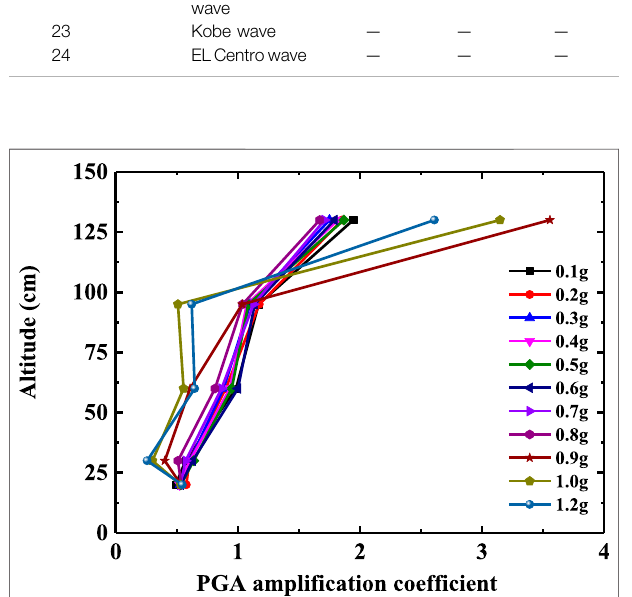
FIGURE6| PGAampli fi cationcoef fi cientofslopesurfaceunderdifferent seismic wave amplitudes.